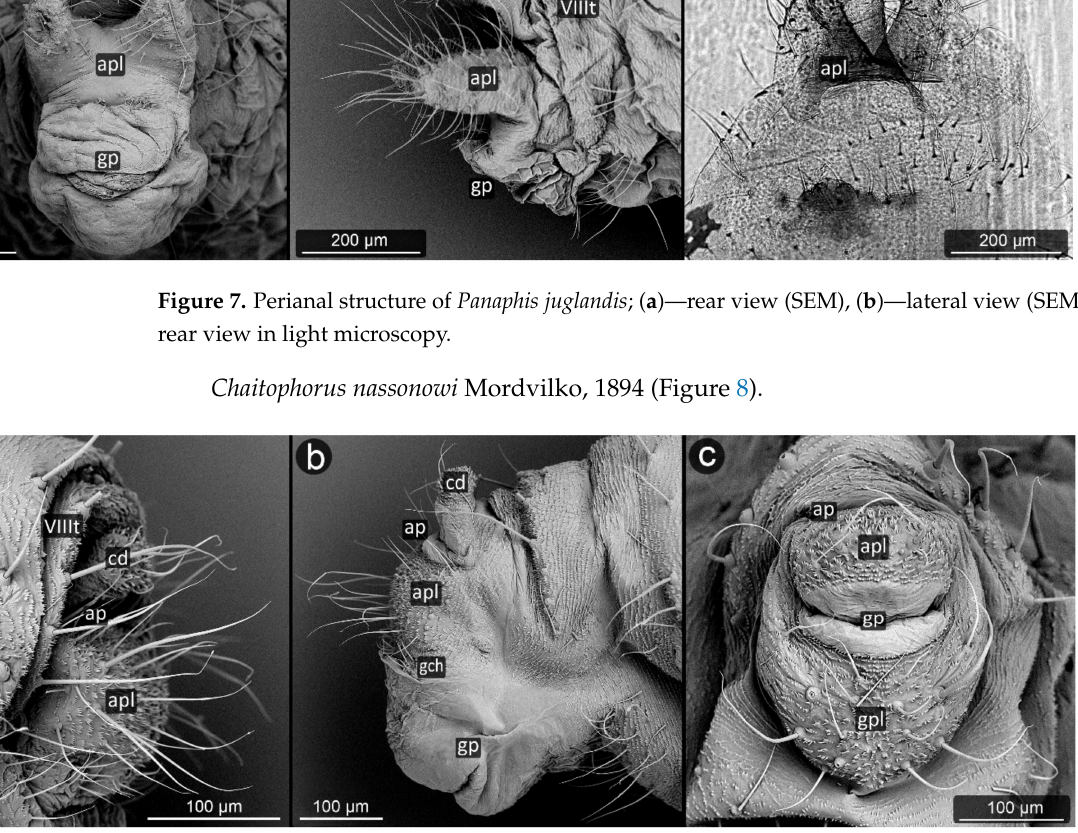
Figure 8. Perianal structure of Chaitophorus nassonowi in SEM; ( a )—lateral view, ( b )—lateral view, ( c )—rear view (cauda [cd] differentiated inside the body). Abdominal tergite VIII: the micro-sculpture strengthens in the border belt at the cauda, where the row of long setae appears. Cauda: small, knobbed, ca. 46 µ m long, covered with cuticular spinules on whole apical